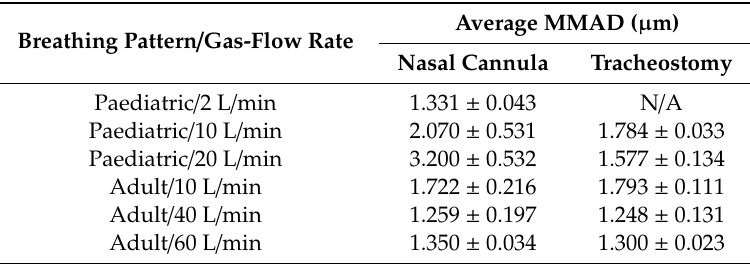
Table 4. Summary of the averaged mass median aerodynamic diameter during each nebulisation event when using two interfaces (nasal cannula and tracheostomy) with three gas-flow rates for simulated adult and paediatric patients, mean and standard deviations over the three